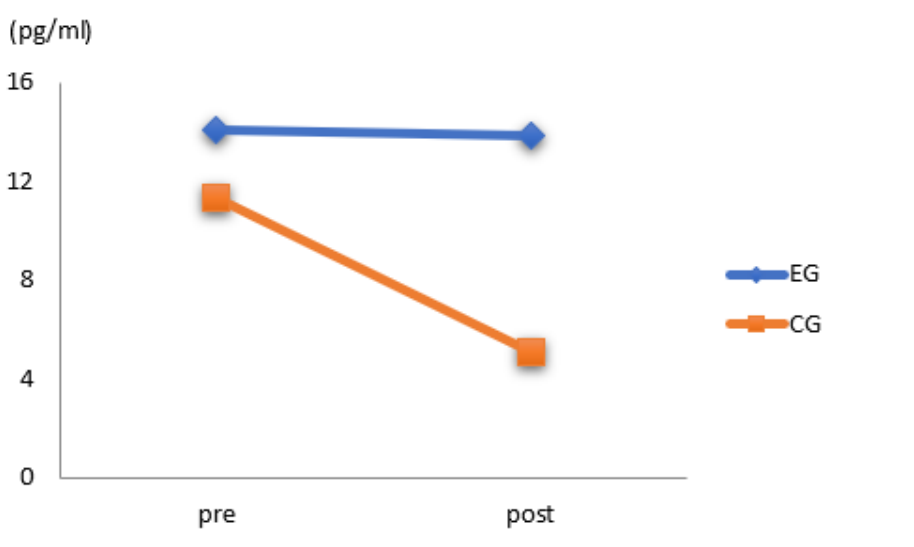
Figure 3. Estradiol